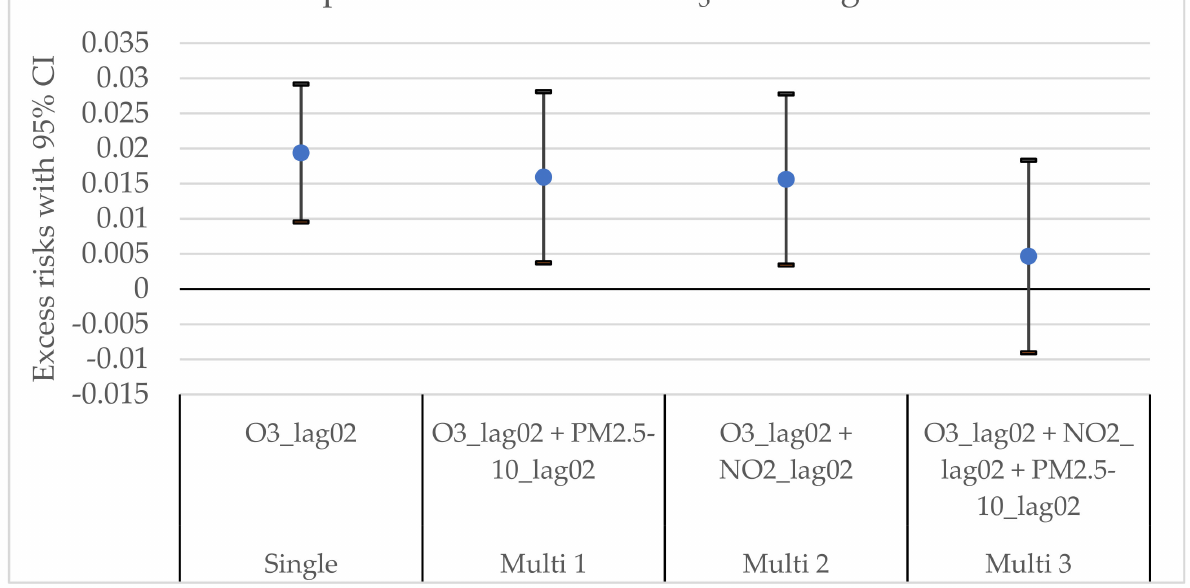
Figure A3. Multi-pollutant models of the estimated change in daily mortality in all ages (with 95% CI) for an IQR increase in the concentration of O 3 (lag02) in Stockholm. From left to right: a single- pollutant estimate of O 3 (Single), O 3 adjusted for PM 2.5–10 (Multi 1), O 3 adjusted for NO 2 (Multi 2), and O 3 adjusted for both NO 2 and PM 2.5–10 (Multi